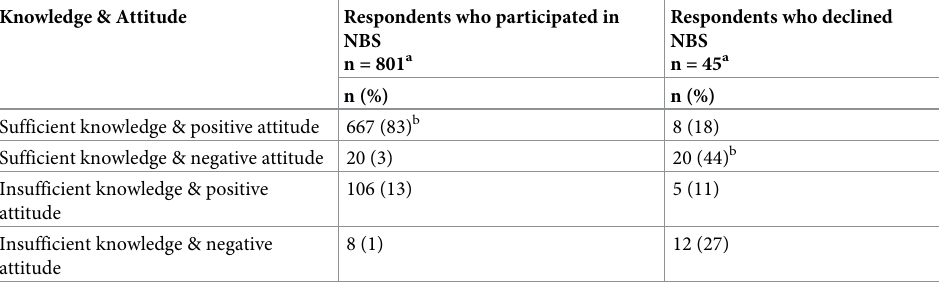
Table 3. Informed decision to participate in NBS or decline